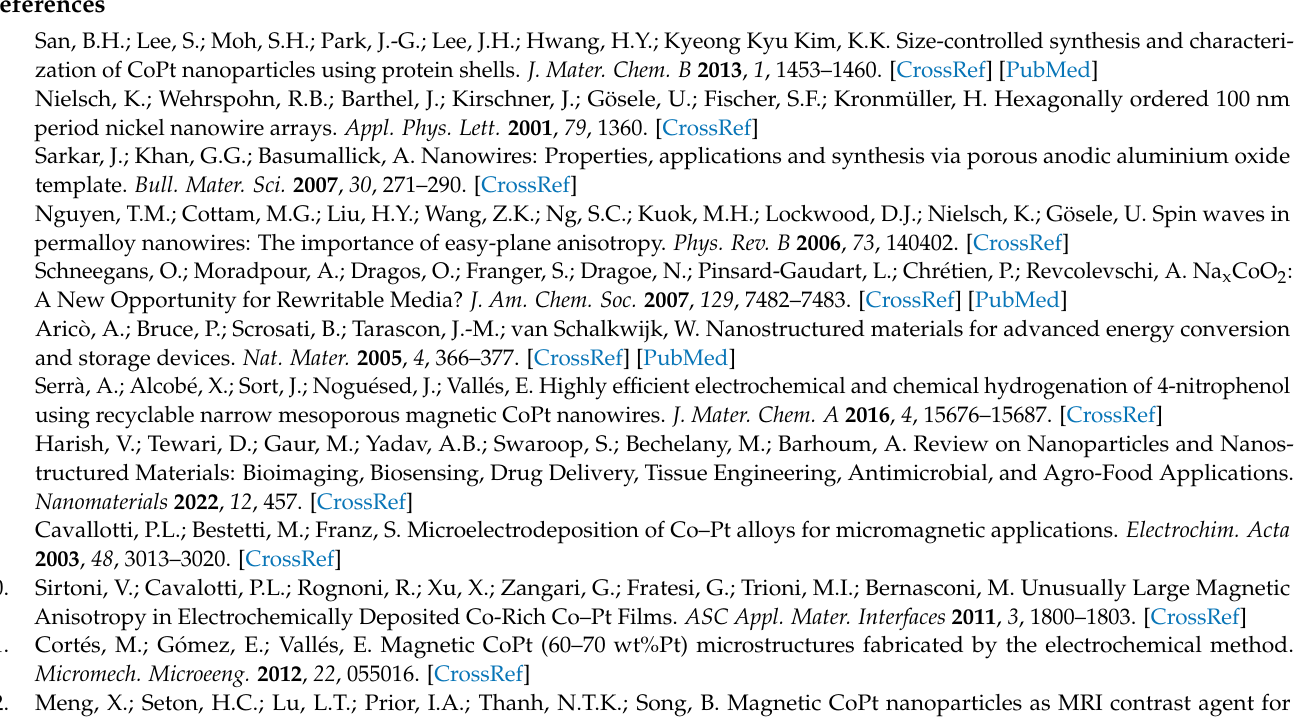
Table S4: EDX analysis of the electrodeposited CoPt thin film from electrochemical bath at pH = 5.5, in presence of